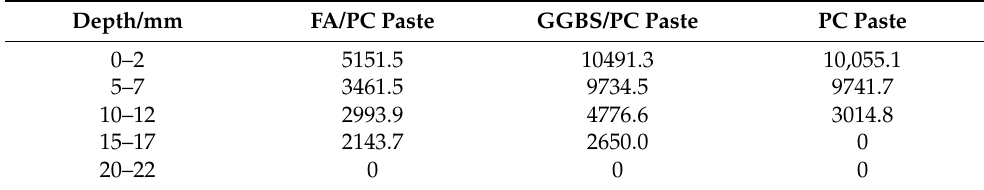
Table 3. Summary of the calcium carbonate content (in terms of peak height) at five depths of carbonated FA/PC, GGBS/PC and PC paste samples under Raman spectroscopy.